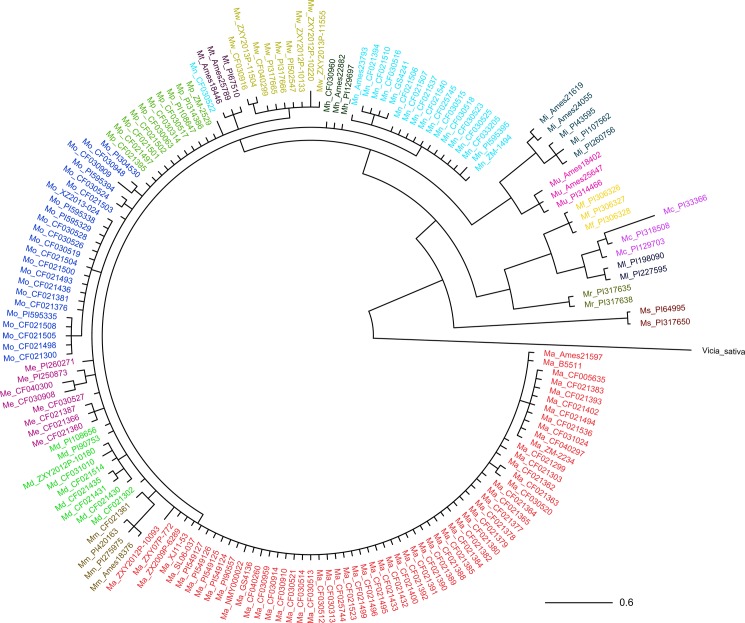
Bayesian tree with branch length, based on ITS sequences.The abbreviations represent 18 species: Ma—M. albus, Mm—M. altissimus, Md—M. dentatus, Me—M. elegans, Mh—M. hirsutus, Mi—M. indicus, Mf—M. infestus, Mr—M. italicus, Mo—M. officinalis, Mp—M. polonicus, Mg—M. segetalis, Mc—M. siculus, Ms—M. speciosus, Mu—M. spicatus, Mn—M. suaveolens, Ml—M. sulcatus, Mt—M. tauricus, and Mw—M. wolgicus.